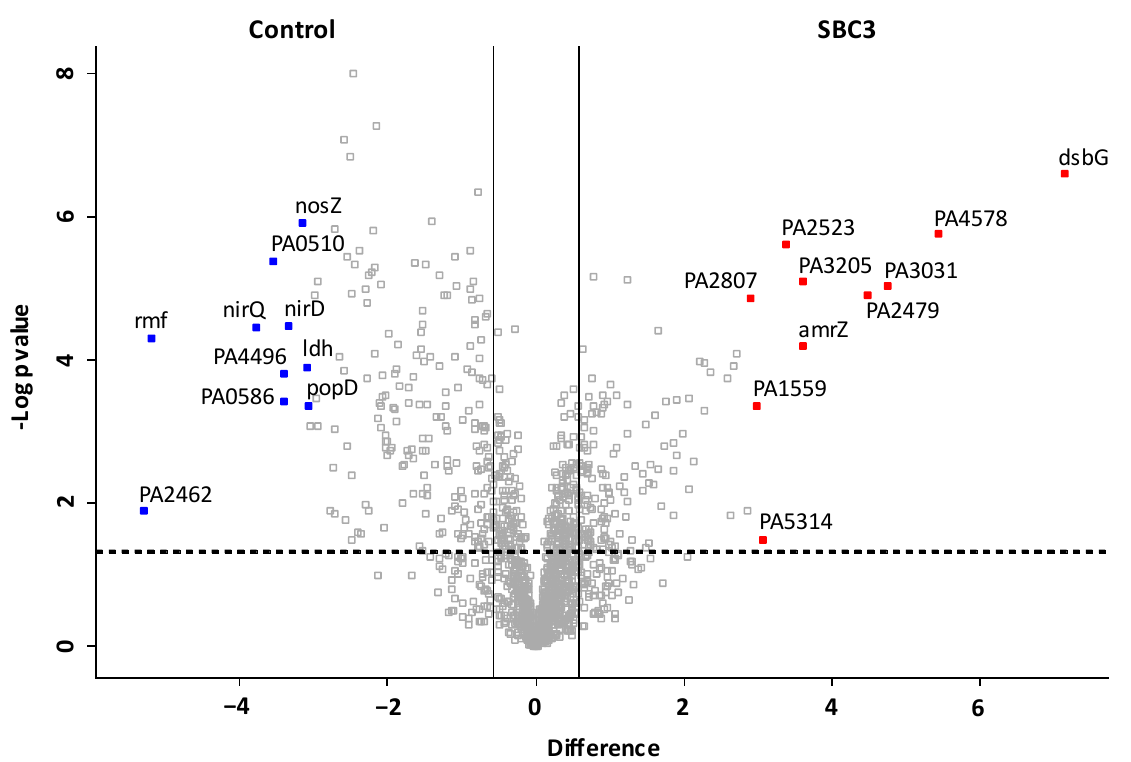
4 of 17 Figure 2. Principal component analysis (PCA) of SBC3-treated P. aeruginosa versus untreated control samples. The distribution of all filtered proteins (1631) is represented on a volcano plot (Figure 3) conducted via a pairwise Student’s t -test ( p < 0.05), and the top ten most differentially abundant proteins (±fold change ≥ 1.5) are highlighted and annotated with associated